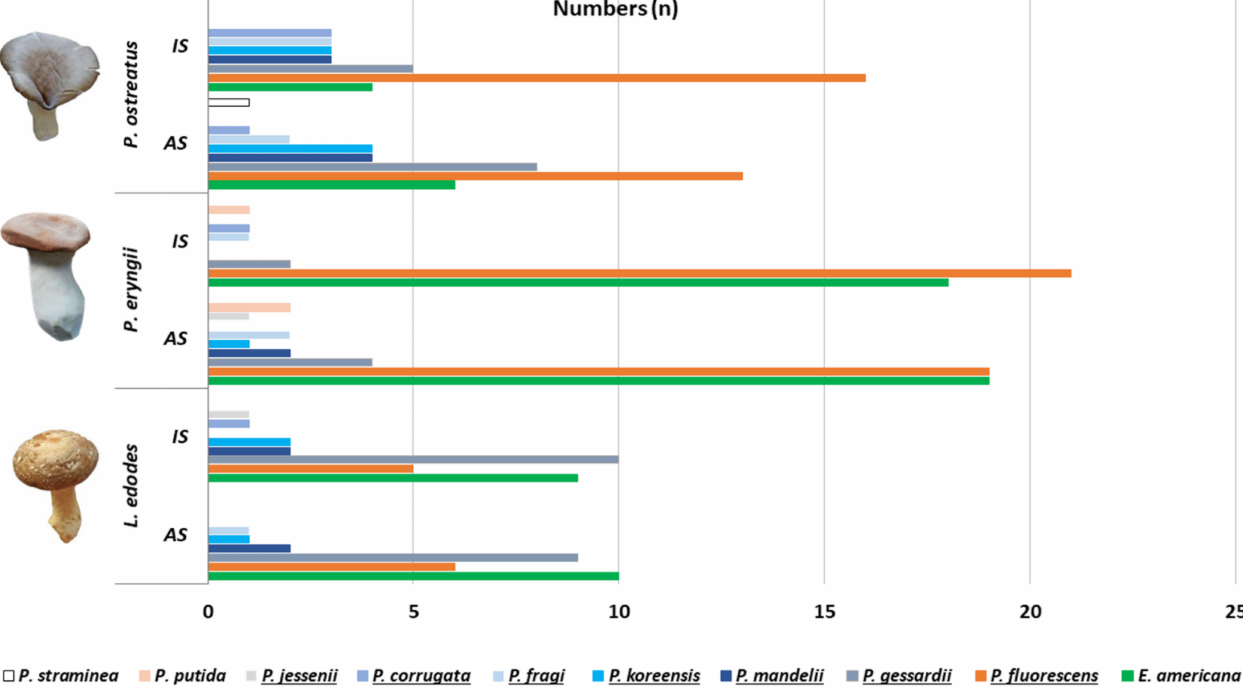
Figure 4. Presence of Pseudomonas groups and Ewingella americana in Pleurotus ostreatus, Pleurotus eryngii and Lentinula edodes analysed on the day of purchase (initial state, IS) and after storage (AS). The Pseudomonas fluorescens species complex was divided into the subgroups P. jessenii, corrugata, fragi, koreensis, mandelii, gessardii and fluorescens